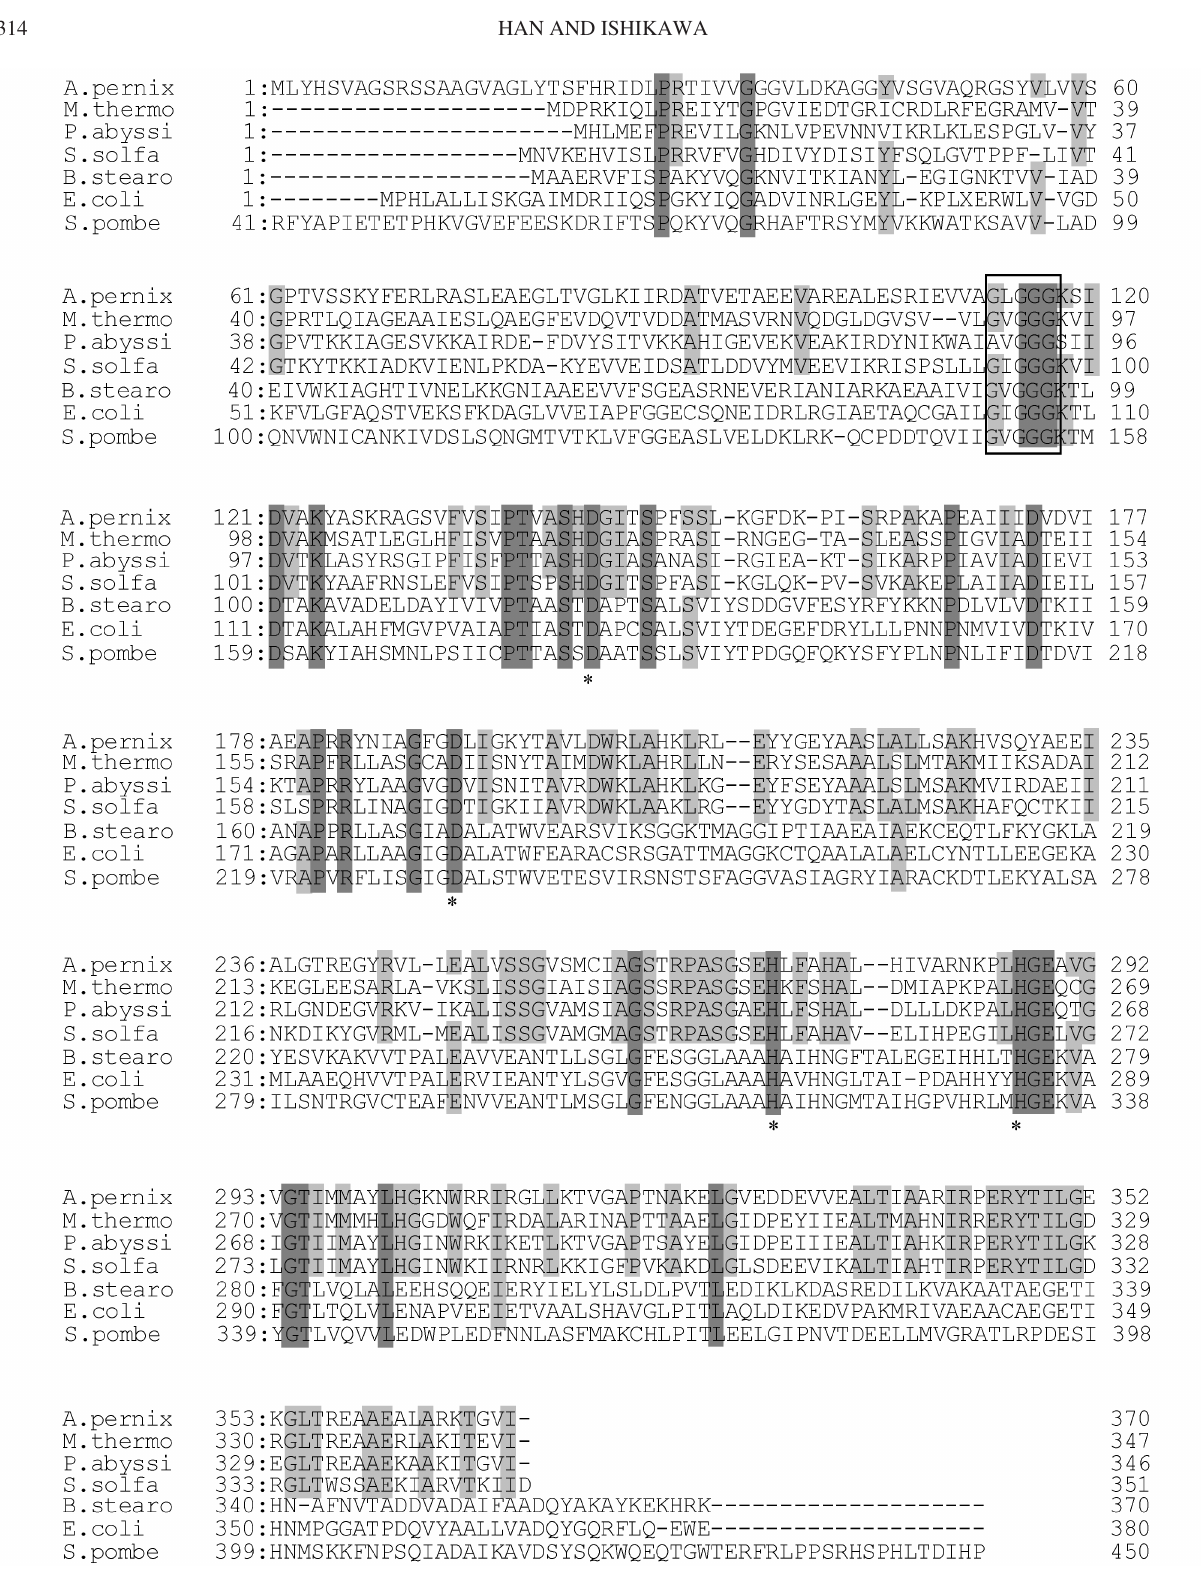
Figure 1. Amino acid alignment of several glycerol dehydrogenases (GroDHs) together with sn -glycerol-1-phosphate dehydrogenase (Gro1 P DH) of Aeropyrum pernix K1 . Archaeal Gro1 P DH: Methanobacterium thermoautotrophicum (M. thermo; 370 aa); Pyrococcus abyssi (P. abyssi; 346 aa); and Sulfolobus solfataricus (S. solfa; 351 aa). Bacterialor eukaryotic GroDH: Bacillus stearothermophilus (B. stearo; 370 aa); Escherichia coli (E. coli; 380 aa); and Schizosaccharomyces pombe (S. pombe; 450 aa). Amino acid residues that are identical in all sequences are shaded in dark gray, and residues that are identical in all Gro1 P DHs are shaded in light gray. Asterisks indicate amino acid residues changed by site-directed mutagenesis. The box indicates the NAD(P)H binding